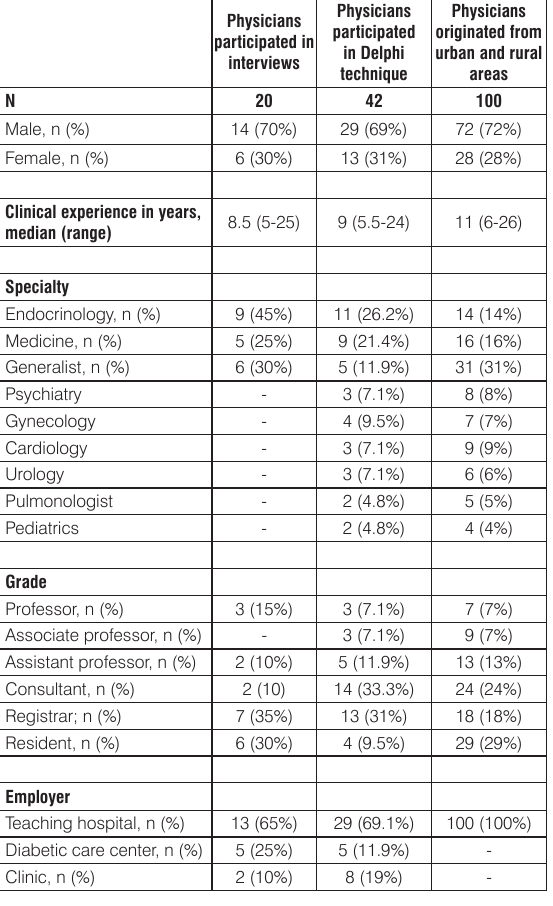
Table 1 lists the gender of all participant physicians in the three phases of the study, their range of experience in years, their practice specialties, grades and